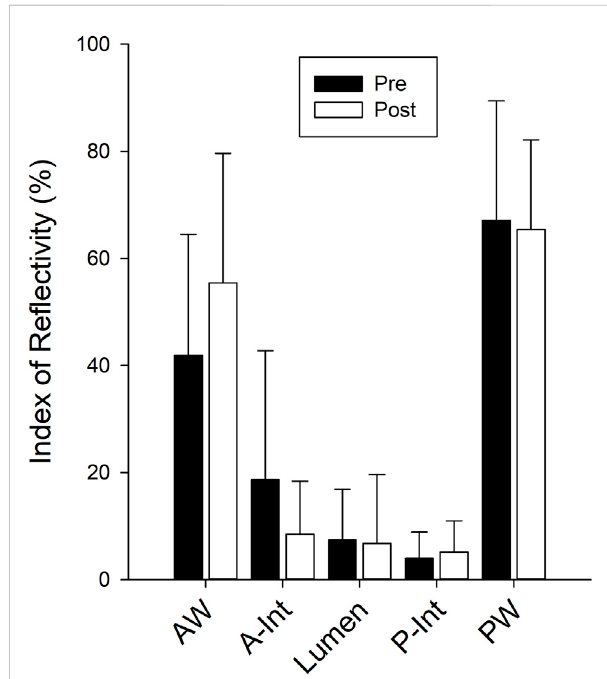
FIGURE 5 Bars represent the mean ± SD for the Carotid index of re fl ectivity calculated from the recorded radiofrequency signal for the anterior wall(AW),anteriorintima(A-Int),vessellumen,posteriorintima(P-Int), and posterior wall (PW) of the common carotid artery (n = 12 for all measures). There were no differences between values calculated pre isolation (black bars) and post isolation (white